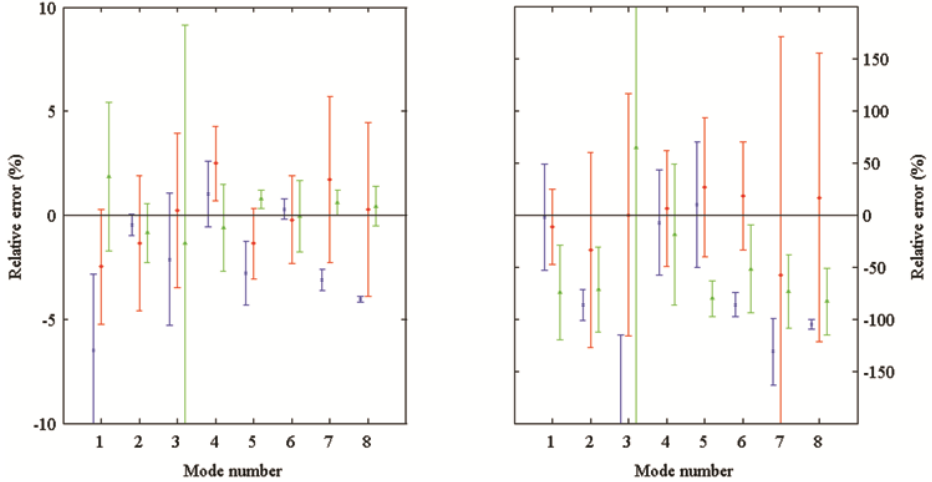
Fig. 11. Relative error of the resonant frequencies (left) and damping ratios (right) with 95% confidence bounds, OMA TM (blue), EMA FRF (red) and OMA XP + (green) based estimates. It follows that the transmissibility OMA approach performs quite well, albeit not as good as the FRF or even the crosspower-based estimates.